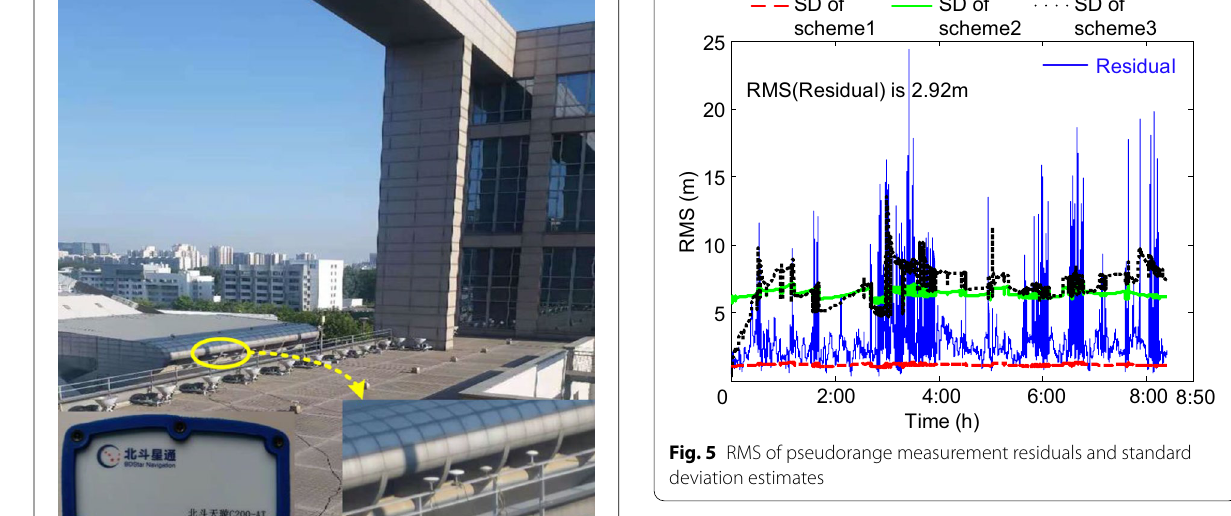
epoch. Figure 6 illustrates the pseudorange measurement residuals and standard deviation for each observed satel- lite. In figures, the blue curve represents the pseudorange measurement residuals. The red, green, and black curves represent the pseudorange Standard Deviations (SD) estimated by the general empirical model in Scheme 1,